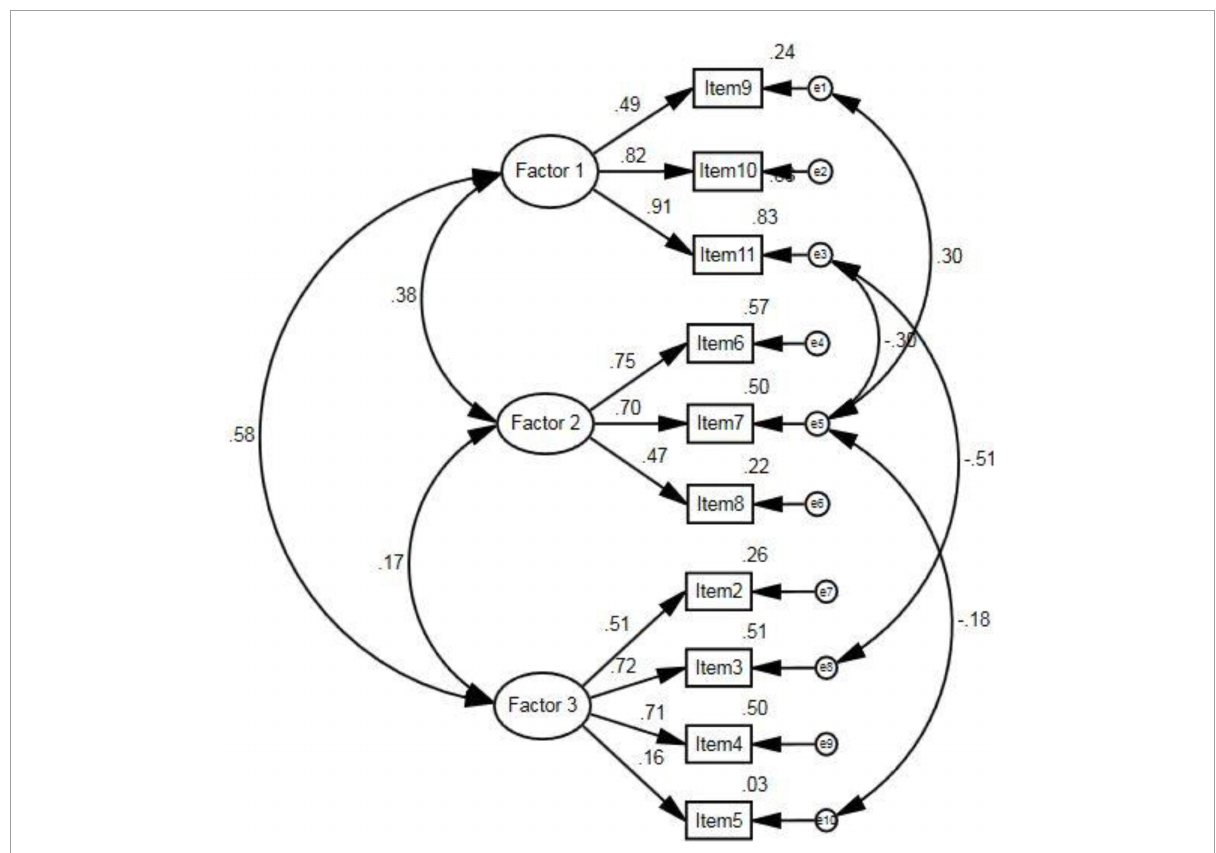
FIGURE1 The confirmatory factor analysis of the Persian Version of the Moral Injury Symptoms Scale-Health Care Professionals